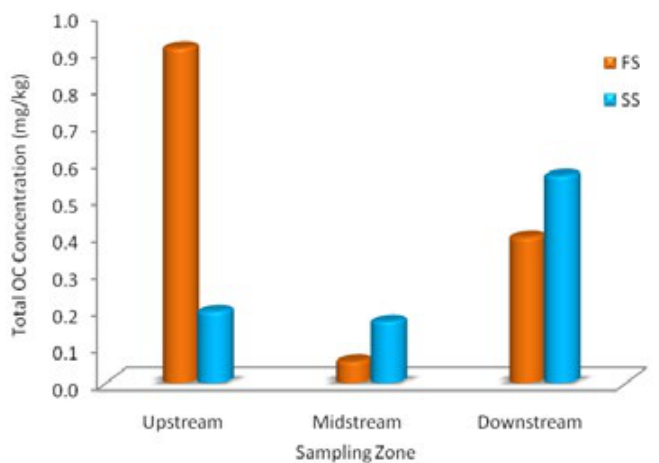
Fig. 2: Total OC residual levels in fish and sediment acroos sampling zones